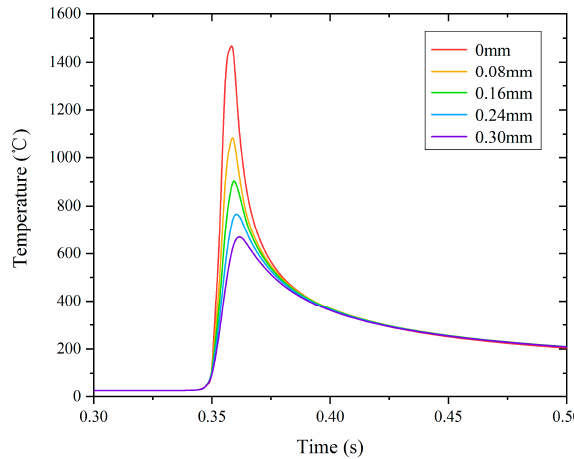
Figure 5. Temperature history for di ff erent depth values measured from the free Figure 5. Temperature history for different depth values measured from the free surface. Figure 5. Temperature history for different depth values measured from the free surface. Figure 5. Temperature history for different depth values measured from the free surface.